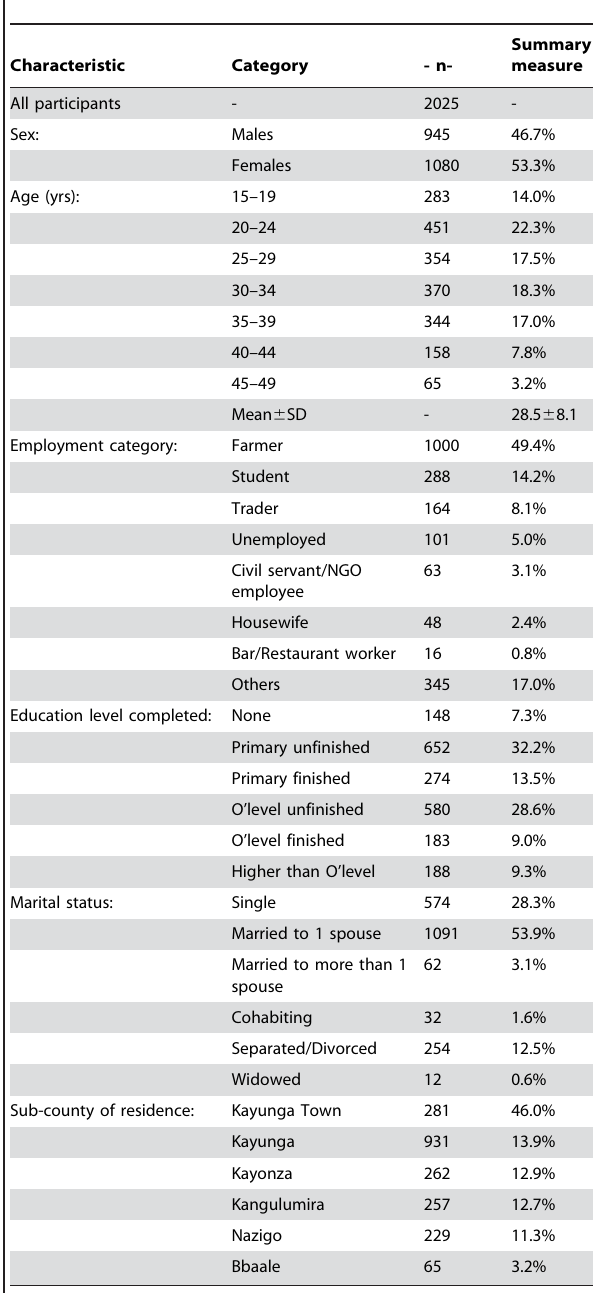
Table 1. Baseline demographic and social characteristics of